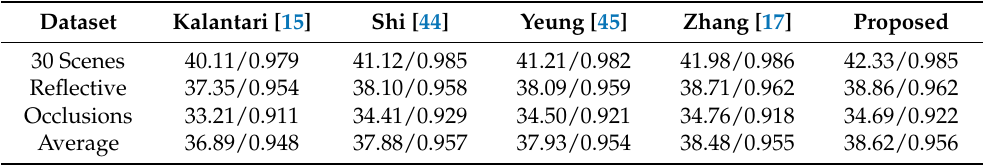
Table 1. Numerical comparison (PSNR/SSIM) of the proposed model for LF reconstruction using